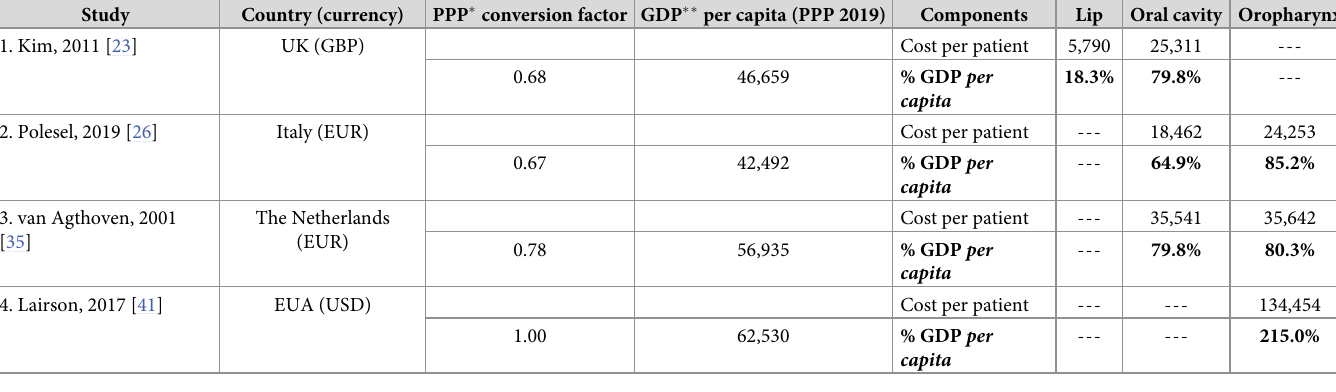
Table 6. Burden of cost of lip, oral cavity, and oropharynx cancers according to Gross Domestic Product per capita.